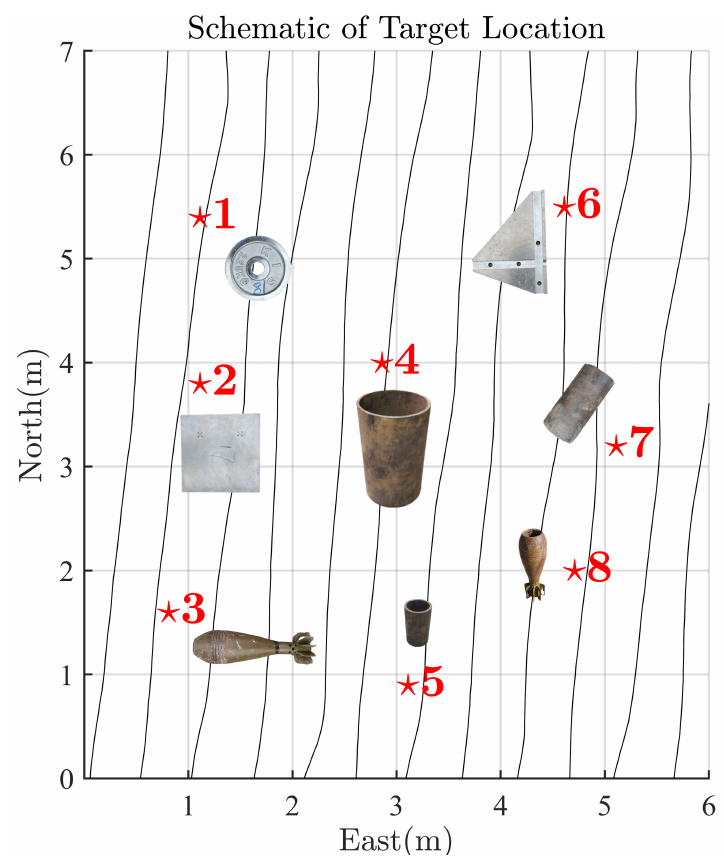
Figure 12. Schematic of the target location.